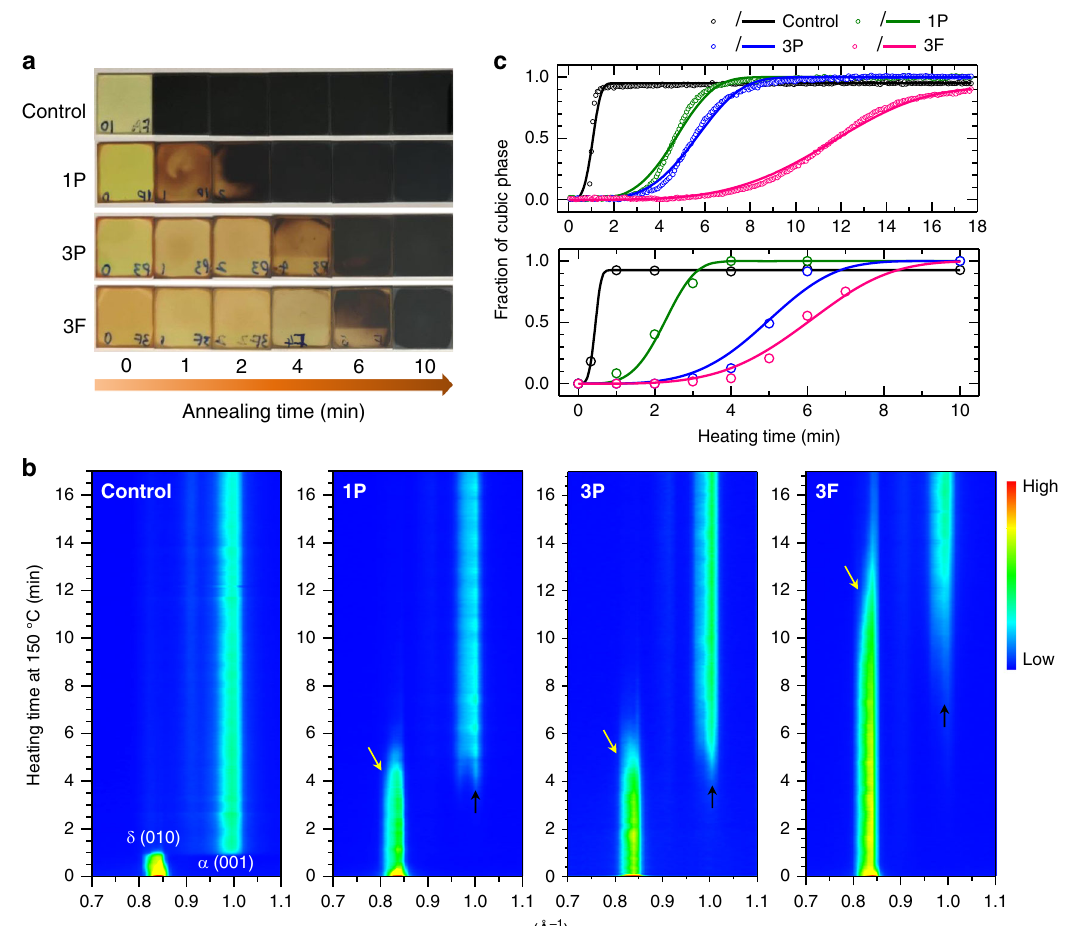
Fig. 1 Phase conversion kinetics of formamidinium lead tri-iodide (FAPbI 3 ) perovskite with a hetero-interface at the grain boundaries. a Photographs of FAPbI 3 fi lms on SnO 2 -coated ITO substrates with different annealing times at 150 °C. Control: bare FAPbI 3 , 1P: FAPbI 3 with 1.67 mol% PEA 2 PbI 4 , 3P: FAPbI 3 with 3.33 mol% PEA 2 PbI 4 , and 3F: FAPbI 3 with 3.33 mol% FPEA 2 PbI 4 . b In situ grazing incident wide angle X-ray scattering (GIWAXS) measurements of corresponding fi lms deposited on silicon wafer substrates. c Isothermal transformation diagrams showing the evolution of the α -FAPbI 3 phase proportion in the fi lms as a function of annealing time at 150 °C on silicon wafers (upper panel) and on SnO 2 -coated ITO substrates (lower